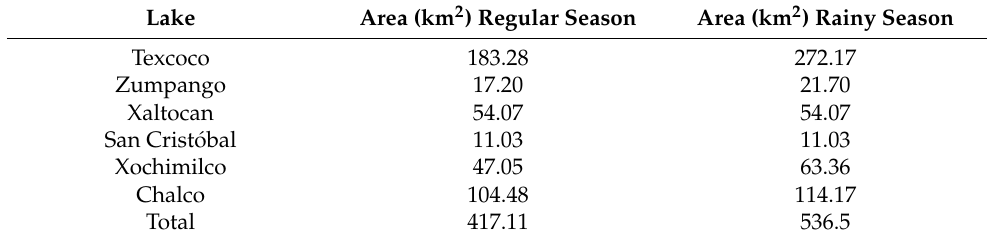
Table 1. Lake surface on the Valley of Mexico in